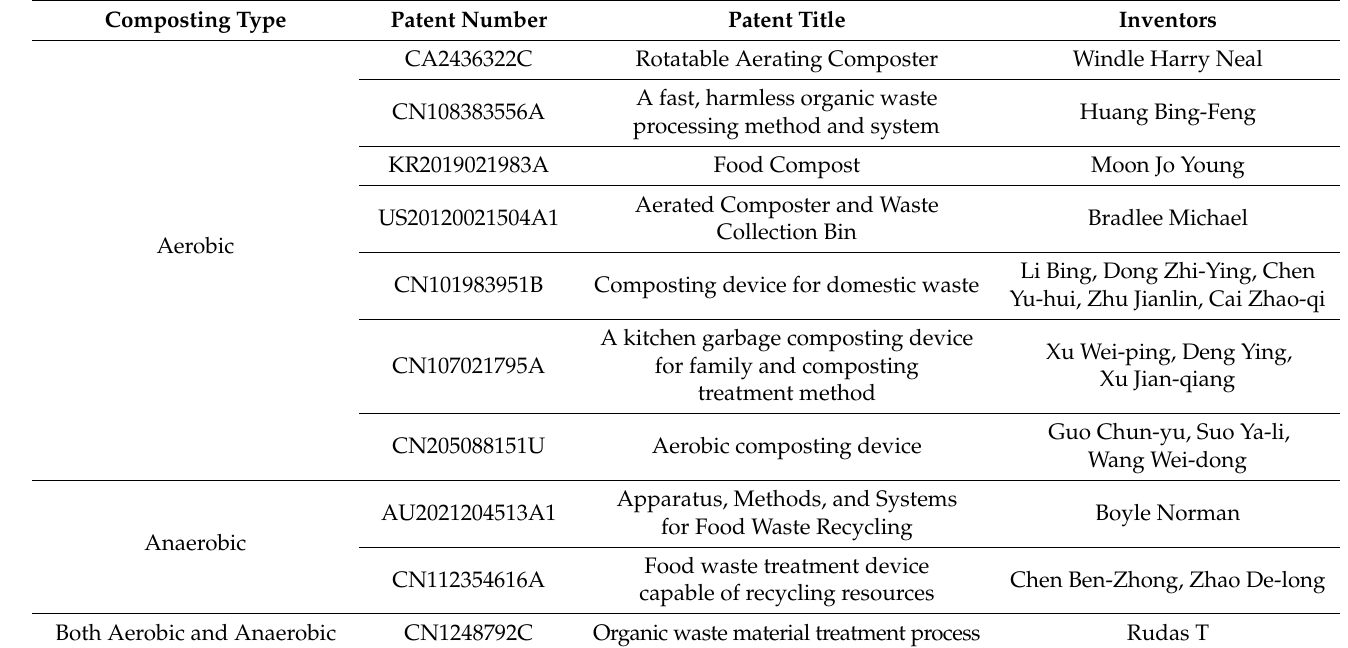
Table 10. Classification of the partially automated composting